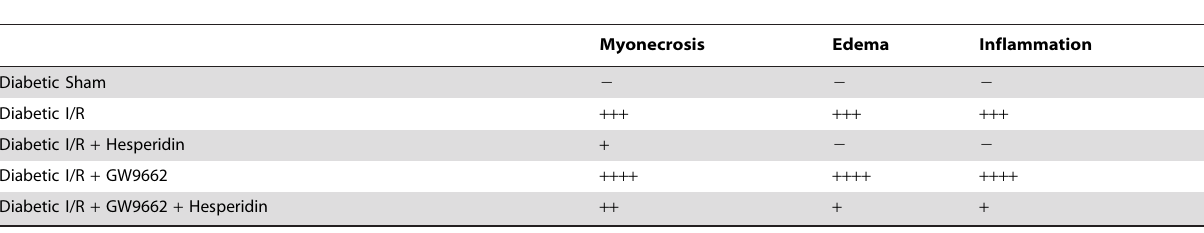
Table 3. Histopathological changes in all experimental groups.